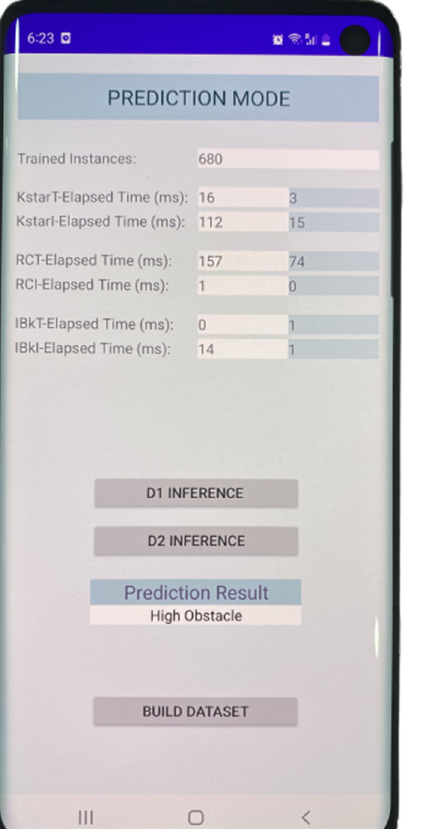
Table 5. Dataset 1 (D1) Sample.